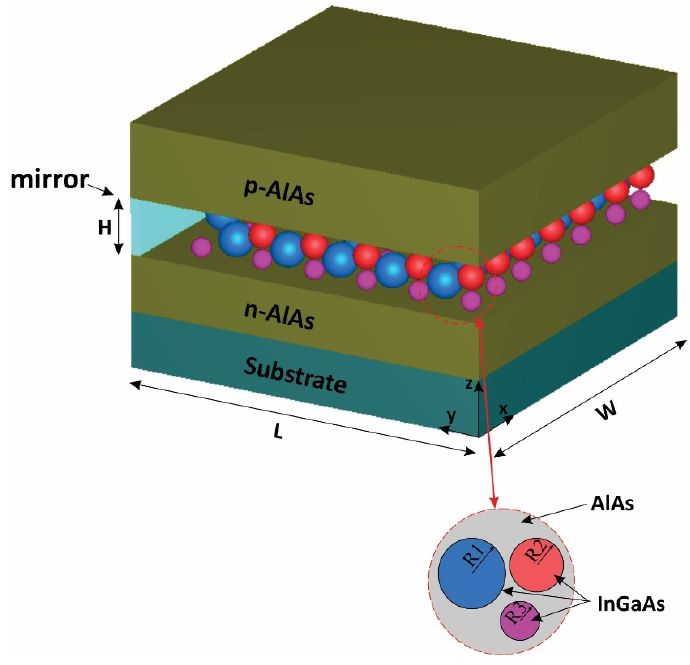
Figure 1. The proposed structure for three groups of quantum dots.